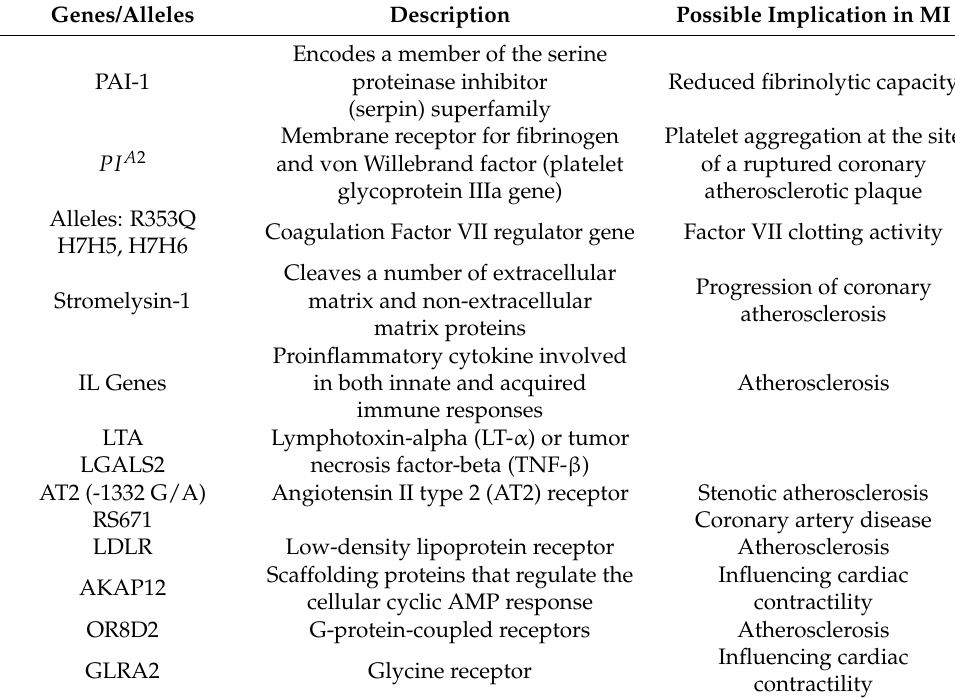
Table 1. The most important genes/alleles associated with acute myocardial infarction.